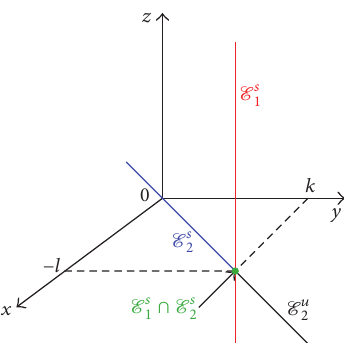
Figure 3: The diagram of equilibrium